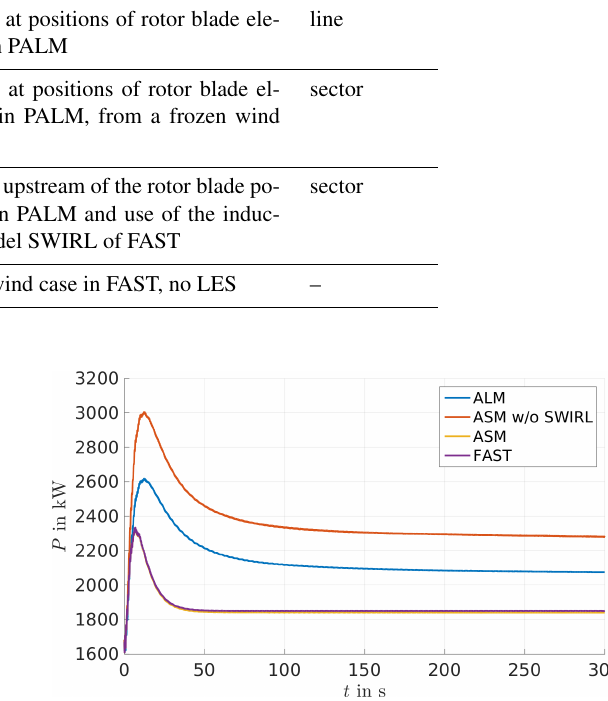
Figure 2. Comparison of different simulation methods for the gen- erator power of the 5MW NREL turbine in a laminar flow with 8ms − 1 wind speed.